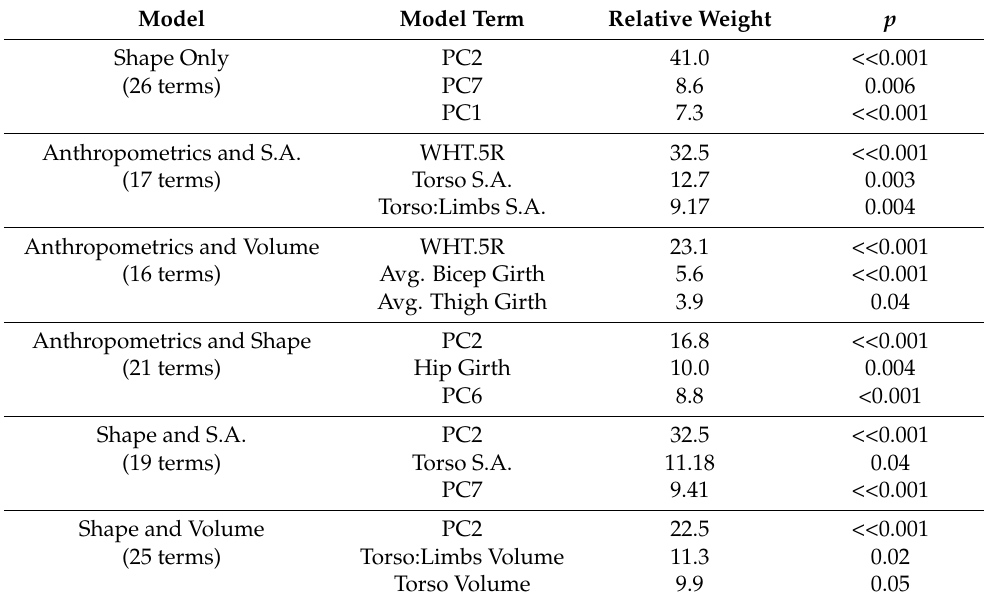
Table 5. Relative weights and associated significances for model terms predicting proportion of fat.